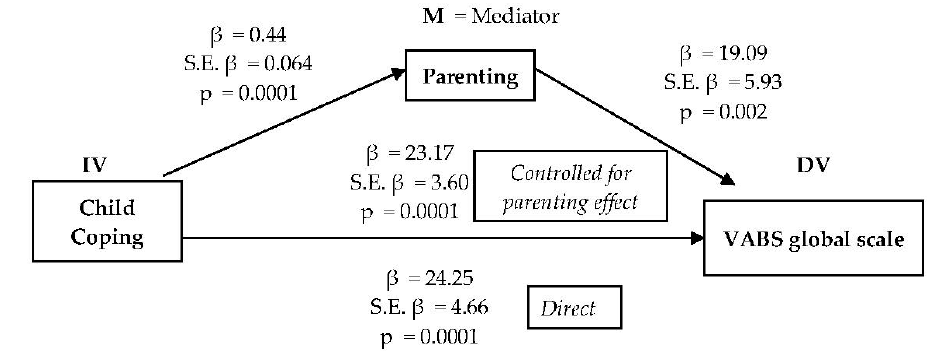
Figure 1. Predictor and mediator factors tested at T1 of the VABS global scale tested at T4. Legend: IV = Independent Variable; DV = Dependent Variable; M =